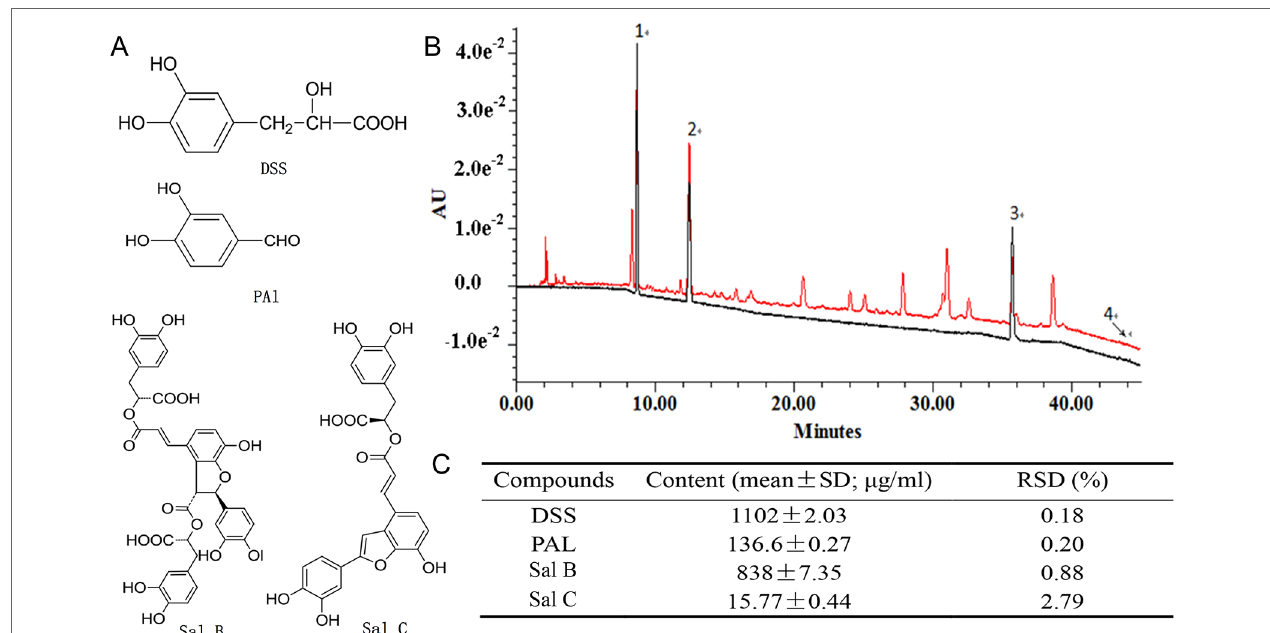
FIGURE 6 | Minimal reconstituted DHI with four compounds. (A) Chemical structures of DSS, Pal, Sal B, and Sal C. (B) UPLC-UV chromatograms of DHI (black) an/d DHI-C4 (red). Peaks: (1) tanshinol (DSS), (2) protocatechuic aldehyde (PAl), (3) salvianolic acid B (Sal B), and (4) salvianolic acid C (Sal C). (C) Quantitation of the four compounds in